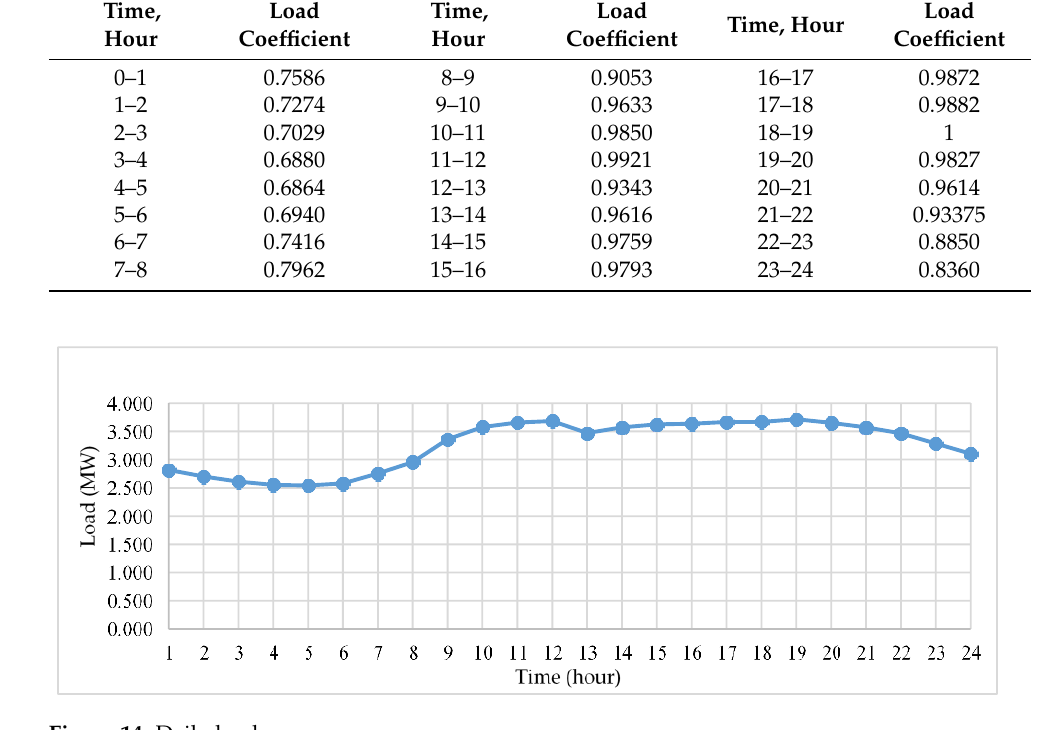
Figure 14. Daily load curve.